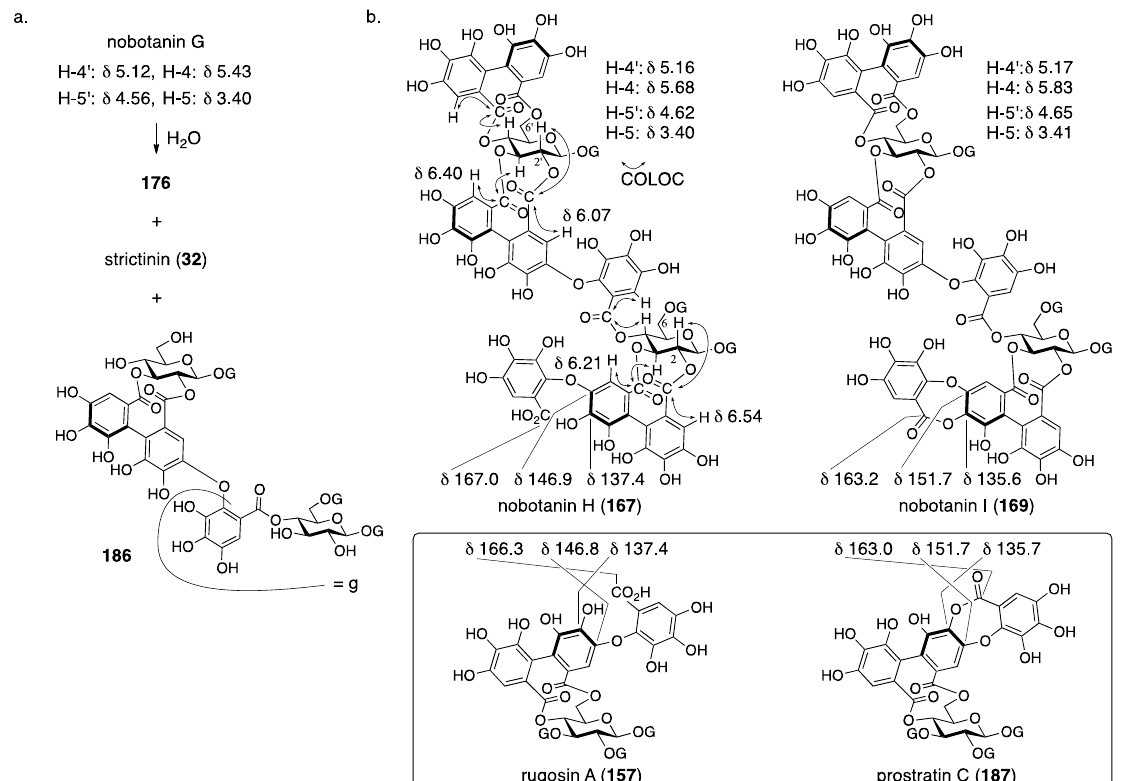
Figure 59. The information that led to the latest structures of nobotanins G, H and I ( 165 , 167 and 169 , respectively). Molecules 2018 , 23 , x FOR PEER REVIEW